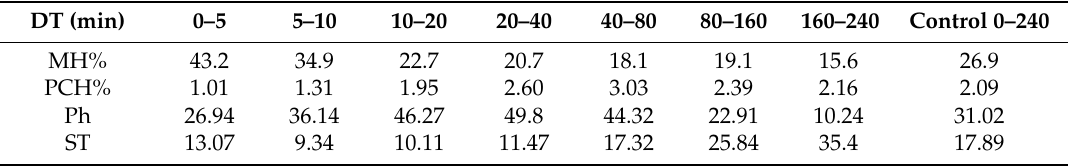
Table 3. Chemical families of Juniperus virginiana essential oil (EO) constituents as a function of their elution during hydrodistillation